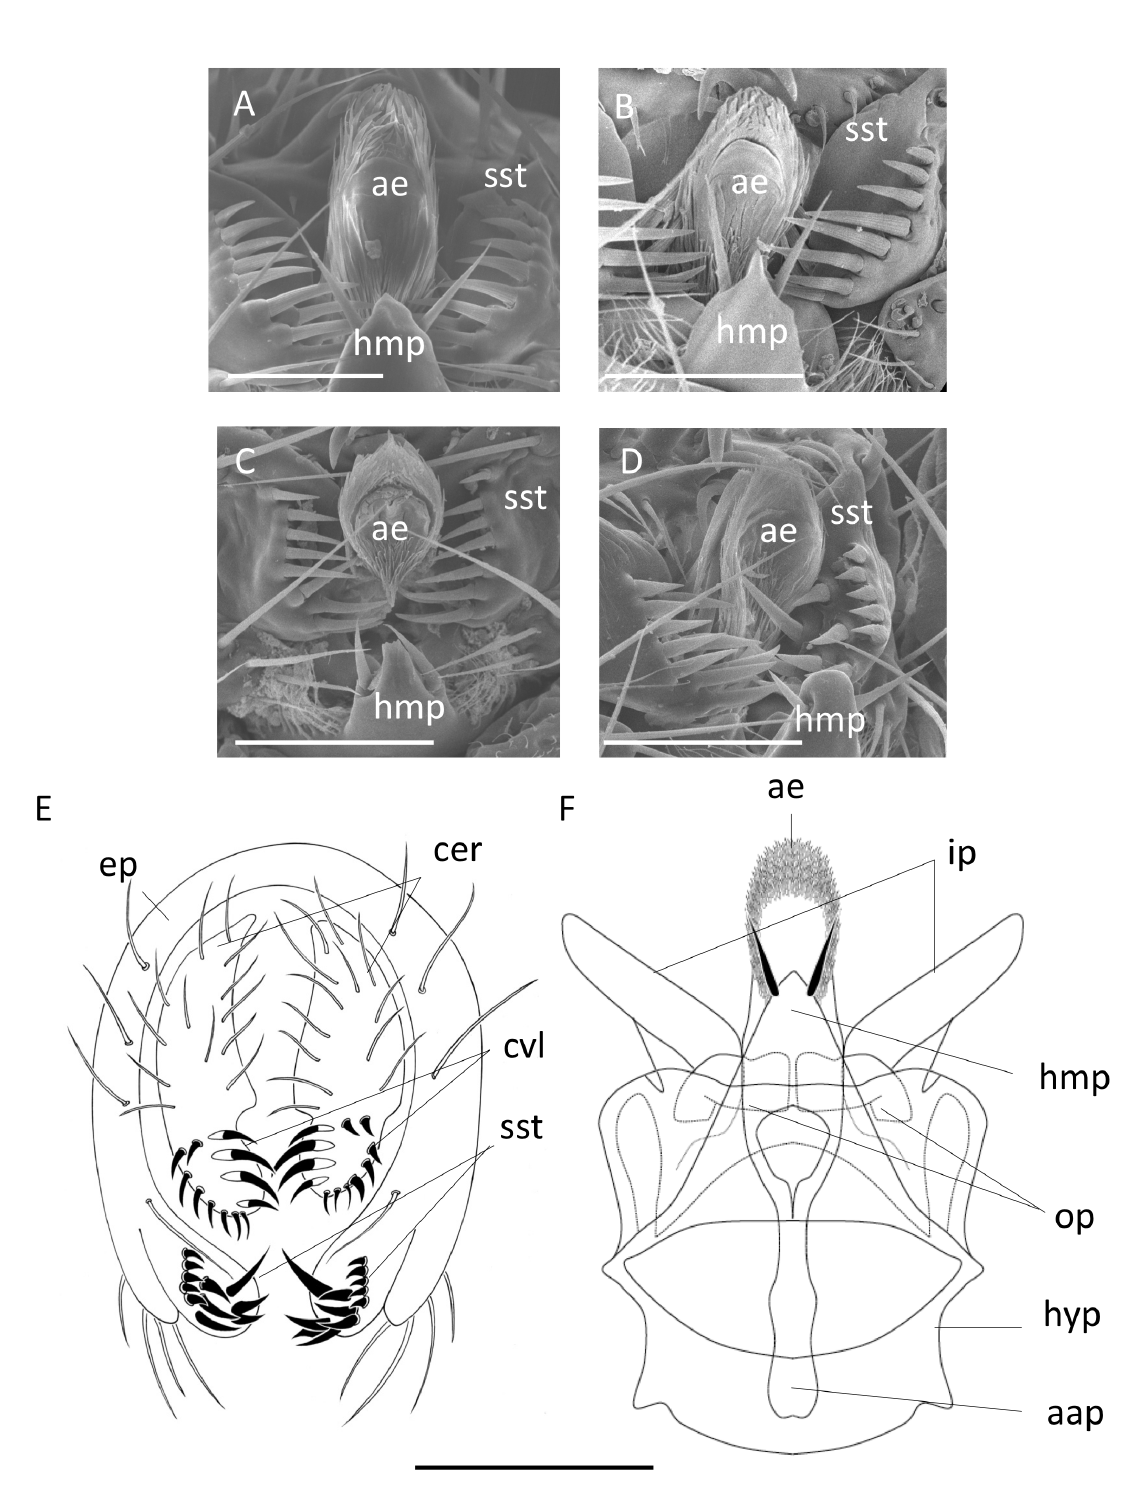
Fig. 5. Male terminalia of the ‘ D. seguyi species complex’. A . D. seguyi Smart, 1945